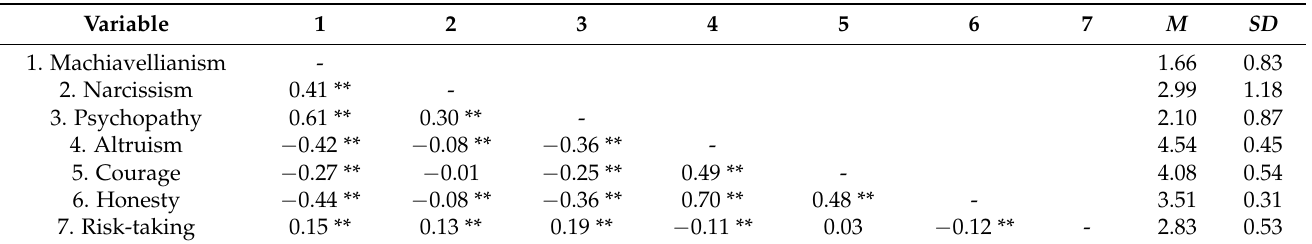
Table 1. Means, standard deviations, and bivariate correlations between all study